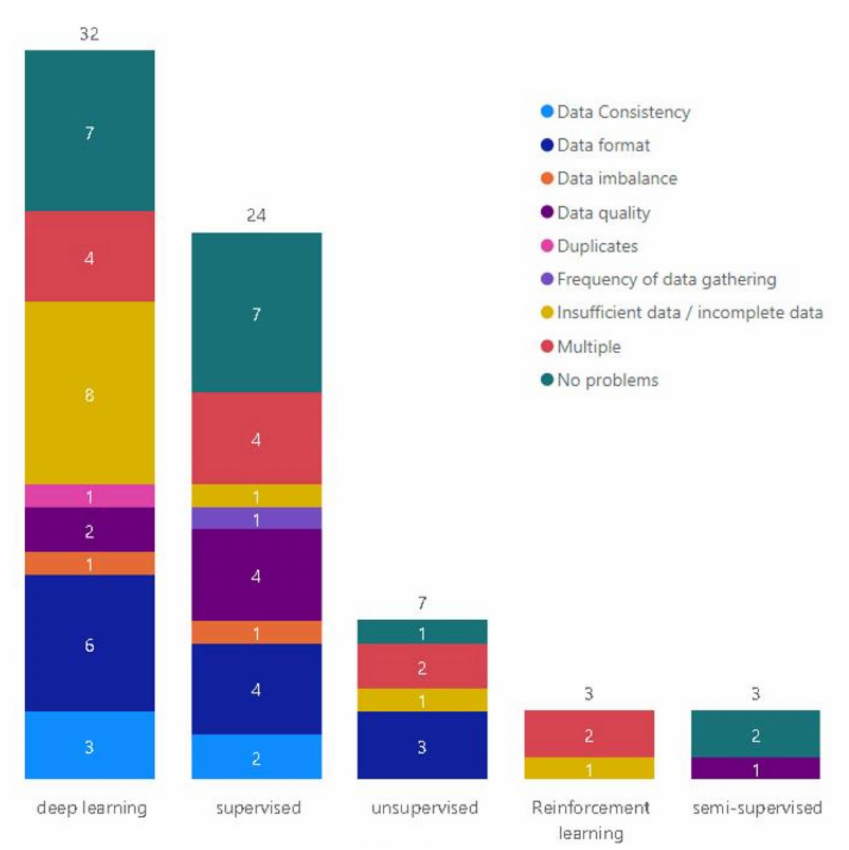
Figure 17. Challenges in open data utilization for each of the ML